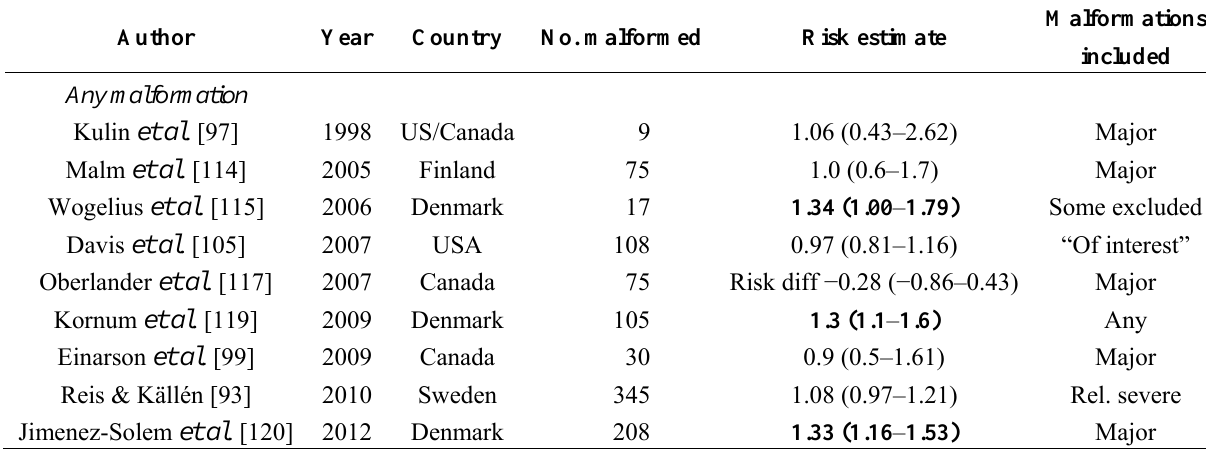
Table 29. Publications describing risks for any malformation after maternal use of antidepressants. Bold text marks statistical significance.